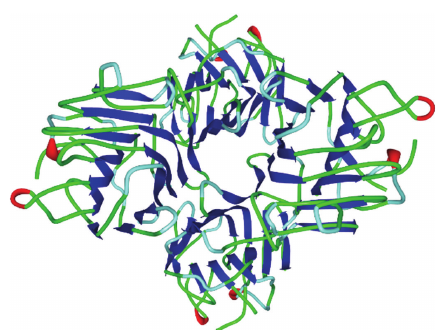
Scheme 9: Structure of concanavalin A (ConA). The glucose- binding sites are shown in red